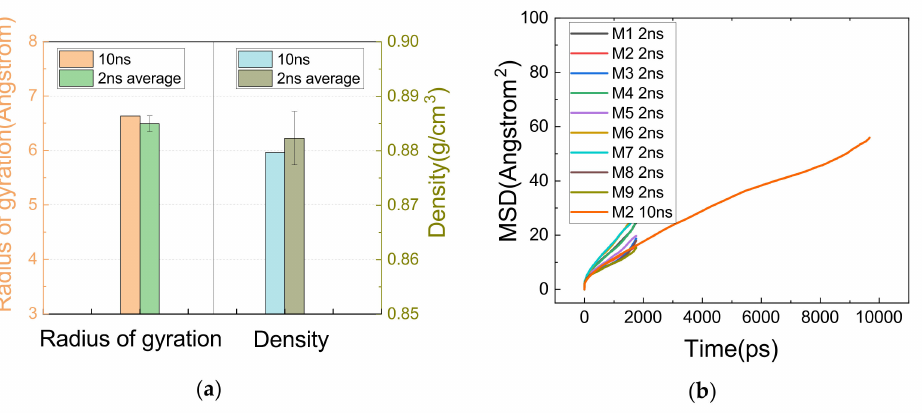
Figure 8. Comparison of results for 10 ns and 2 ns simulations. ( a ) Comparison of density and Rg between 10 ns and 2 ns simulations. ( b ) MSD results for 10 ns and 2 ns.